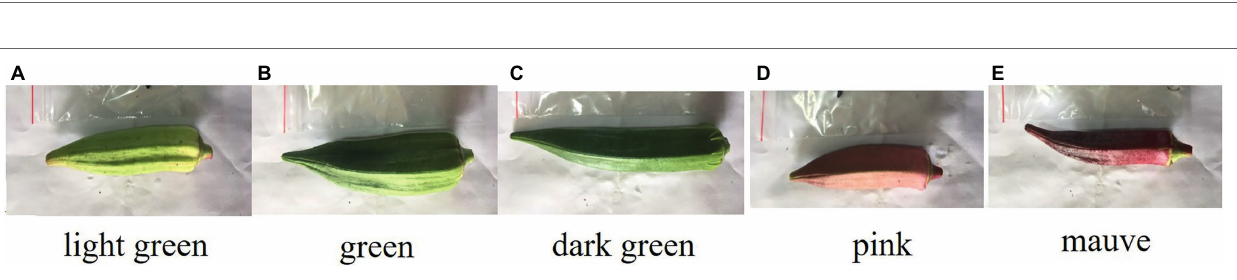
FIGURE 4 | Analysis of the Abelmoschus esculentus germplasm resource population structure. (A) Change in Δ K with K . At K = 7, Δ K corresponded to the peak inflection point, implying the optimal number of populations was 7. (B) Q plot. The y -axis presents the Q values, which reflect the probability of dividing the corresponding material into a specific cluster, with different colors representing different clusters. (C) Neighbor-joining phylogenetic tree based on Nei’s genetic distance. (D) Principal coordinate analysis (PCoA) involving two-dimensional principal coordinates. Both PC1 and PC2 are principal components. The first three principal components explained 76.62% of the variation in the population structure.